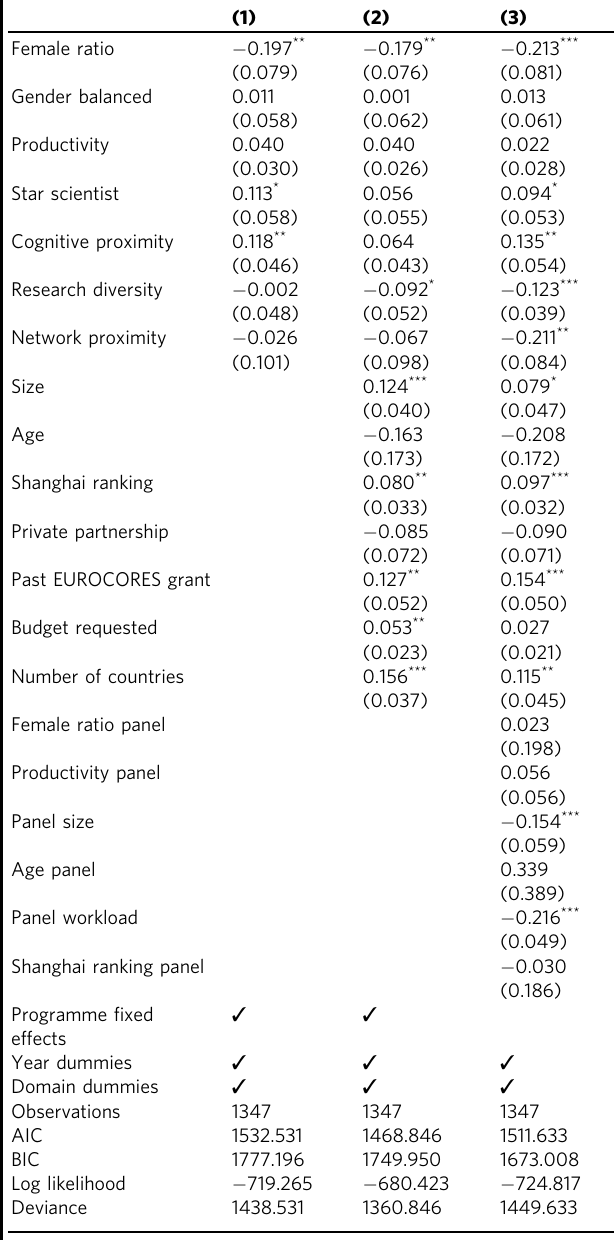
Table 2 Coef fi cient estimates — First expert panel